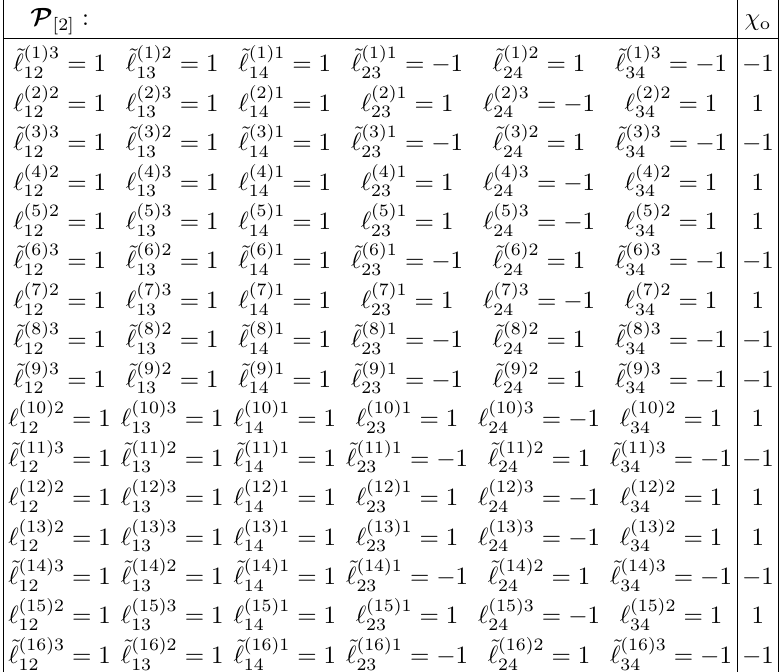
Table 12 . Non-vanishing ‘ , e ‘ , and (cid:31) o values for representation P